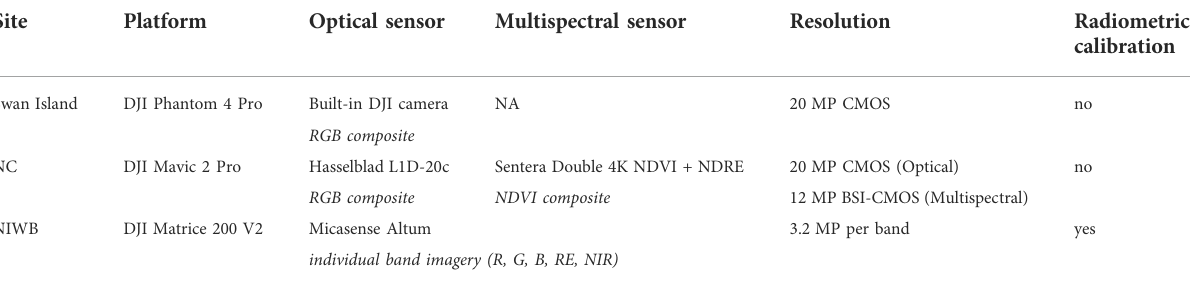
TABLE 1 UAS platforms and sensors used at each site. Optical sensors collect RGB images (Hasselblad and Phantom built-in) or individual Red (R), Green (G), and Blue (B) band imagery post-processed to composite RGB imagery (Altum). Multispectral sensors collect composite NDVI images (Sentera) or individual Red Edge (RE) and Near-Infrared (NIR) imagery post-processed to composite NDVI imagery (Altum). Optical and multispectral sensors are provided with the associated sensor resolutions derived from company-reported platform and sensor speci fi cations.31 –